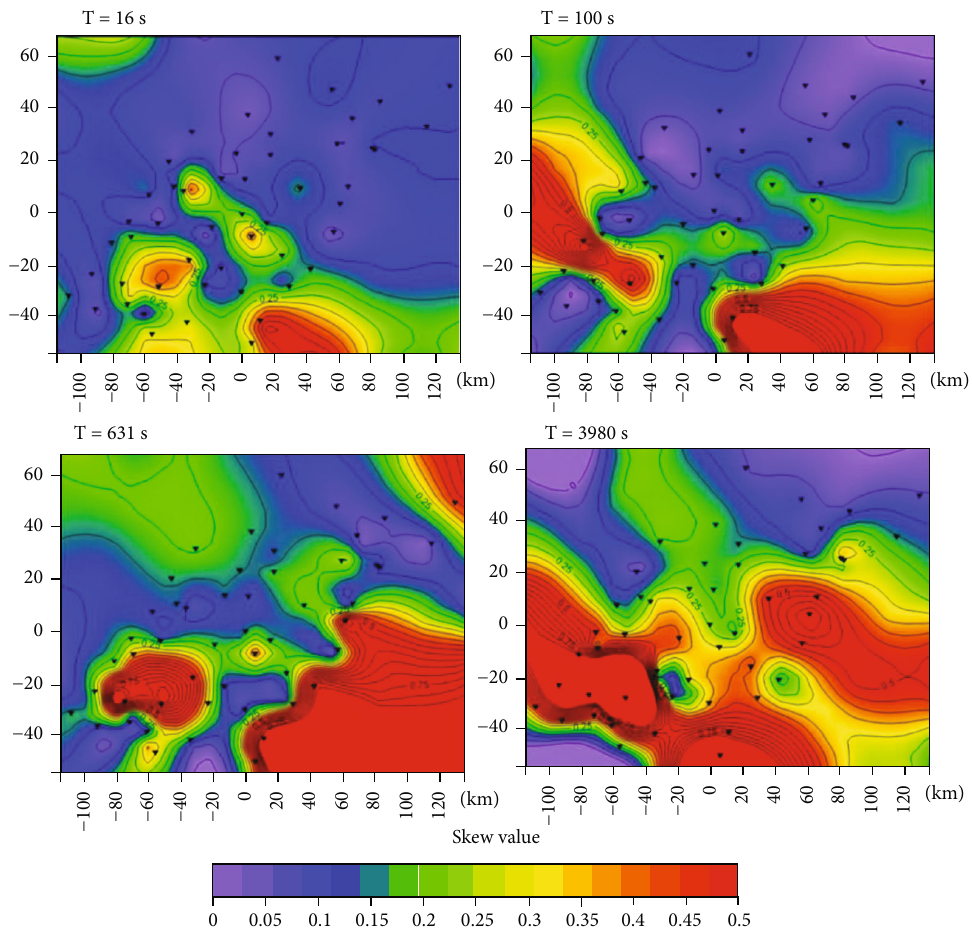
Figure 4: Skew distribution for selected periods (16, 100, 631, and 3980